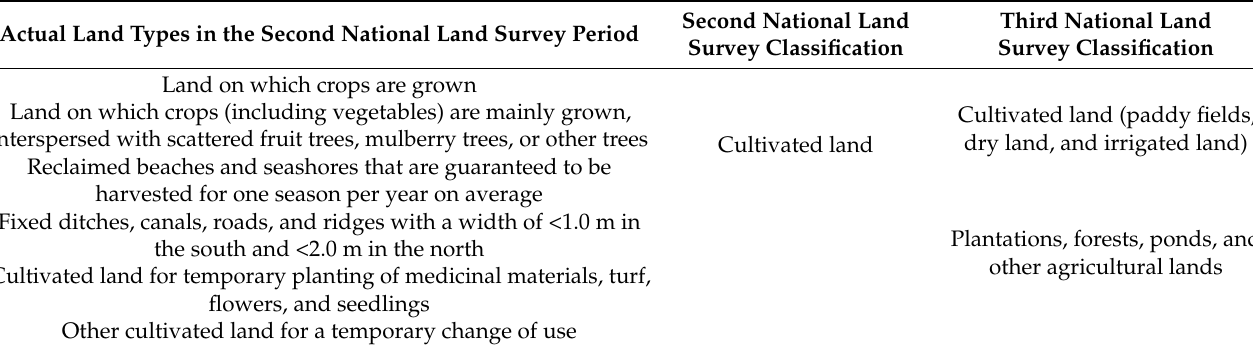
Table 1. Changes of cultivated land identification